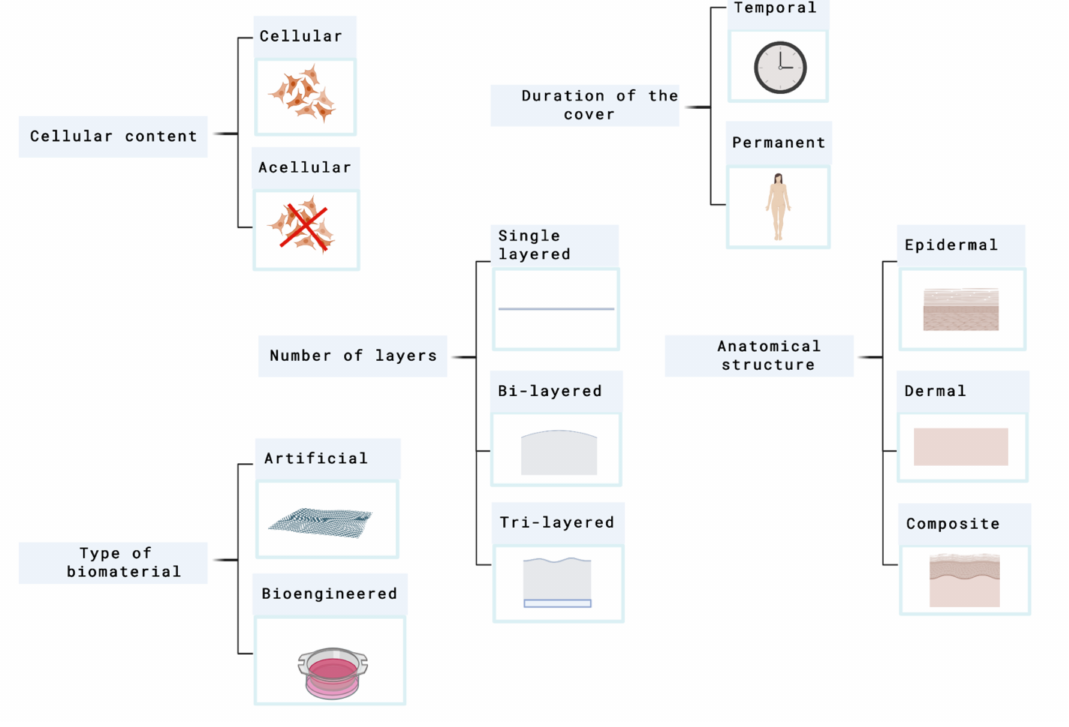
Figure 2. Principal parameters used to classify skin substitutes. Created with